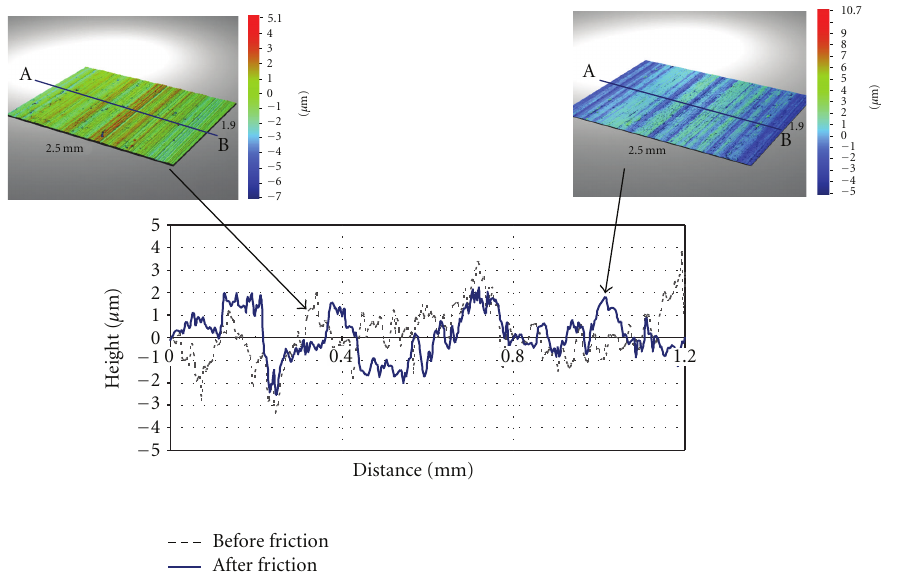
Figure 9: Surface topographies for conditions V = 60m/s and P a = 100 MPa and superposition of the 2D profiles (along the line AB).